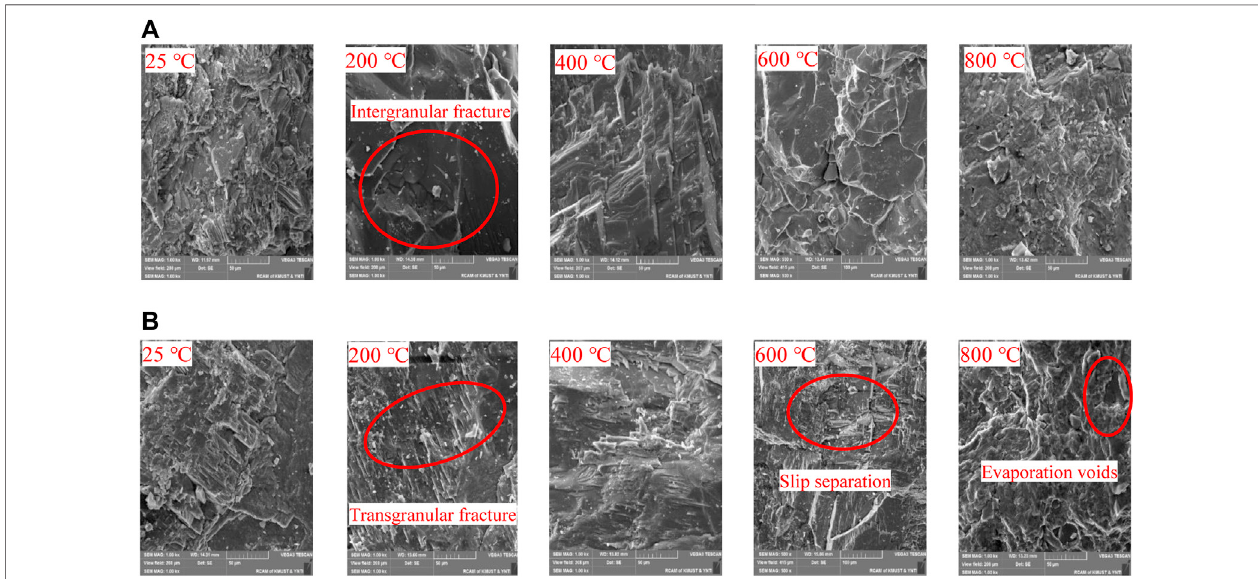
FIGURE 14 | Scanning electron microscopy image of granite at different conditions: (A) impact velocity of 11.5 m/s and (B) impact velocity of 13.5 m/s.